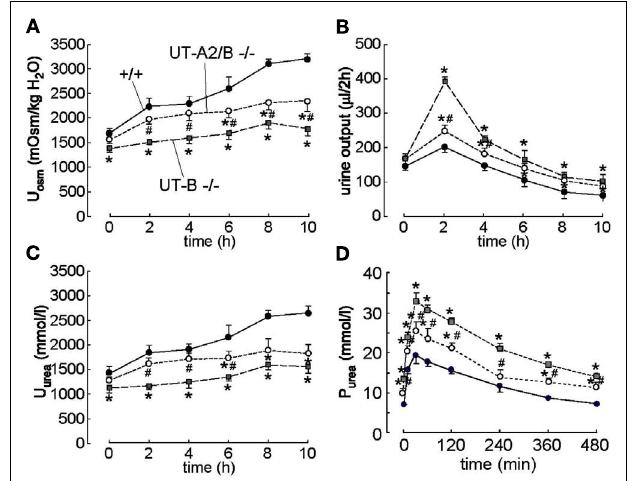
FIGURE 2 | Urea transporter-B knockout and UT-A2/UT-B knockout mouse models. (A) Twenty-four hours urine output in mice of indicated genotype. (B) Urine osmolality measured in mice given free access to food and water (basal) and after an 18-h water deprivation (right; n = 6 mice/group, means ± SE, * p < 0.01 compared withWT mice. # p < 0.01 compared with UT-B KO mice). (C) Urea concentration, sodium concentration, potassium concentration, and chloride concentration in homogenized IM (means ± SE, n = 6. * p < 0.01 compared withWT mice. # p < 0.01 compared with UT-B KO mice). Reproduced from Lei et al. (2011).